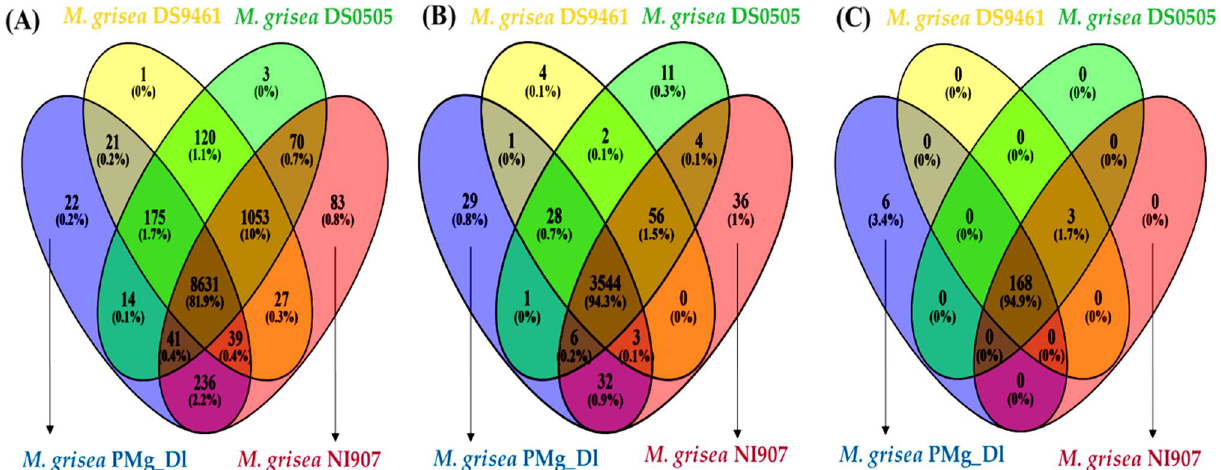
Figure 4. The predicted proteins of M. grisea PMg_Dl and other genomes’ comparative annotation. ( A ) Orthologous genes, ( B ) Protein family (PFAM), and ( C ) CAZymes. In ( C ), the CAZyme families such as AA1, GH109, GH35, GT109, GT61, and PL42 were found uniquely present in M. grisea PMg_Dl, whereas other families, namely, CBM67, GH145, and GH65 were found to be shared among DS9461, DS0505, and NI907genomes.